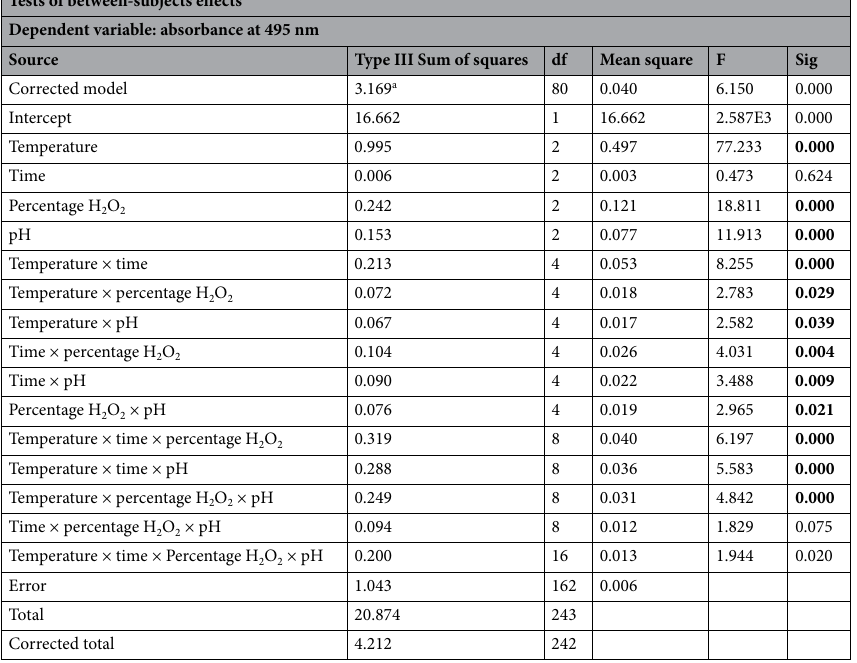
biosurfactant solution (Table 1). Decolorization of polysaccharides derived from C. paliurus increased with an increase in H